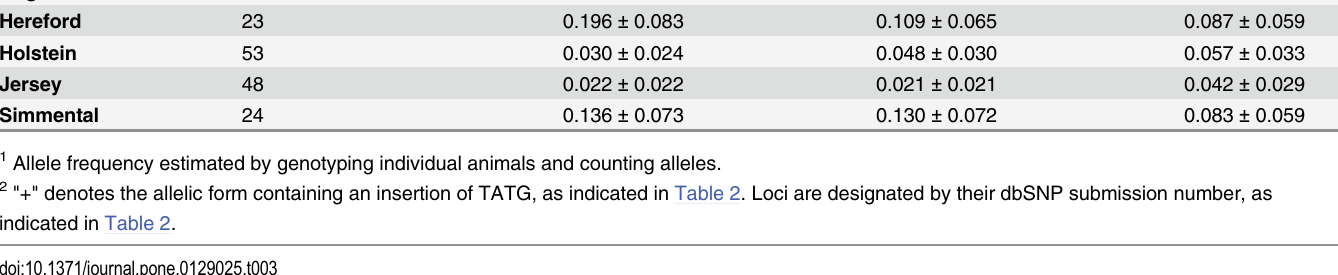
a relatively rare haplotype in association with the high ovulation rate allele (Table 4). The haplo- type associated with increase ovulation rate has the insertion allele at locus 13663941, the A al- lele at locus 14263362 and the A allele at locus 14270483. Linkage disequilibrium between these three loci was variable across breed (Table 5) with a tendency, particularly in the beef breeds, for lower LD between the first and second and first and third loci, and higher LD between the second and third loci, in keeping with the close proximity of the latter two. This relatively infre- quent haplotype has utility for tracking inheritance of the high ovulation rate allele in Trio de- scendants. Frequency of this haplotype ranged from zero to 0.064 within breed (Table 4). Ovulation rate for daughters inheriting alternative haplotypes from Trio were 2.19 ± 0.57 ova for carriers (n = 68) of the high allele versus 1.11 ± 0.22 ova for non-carriers (n = 63). Clas- sification was based on BTA10 haplotypes for non-recombinants within the QTL peak region